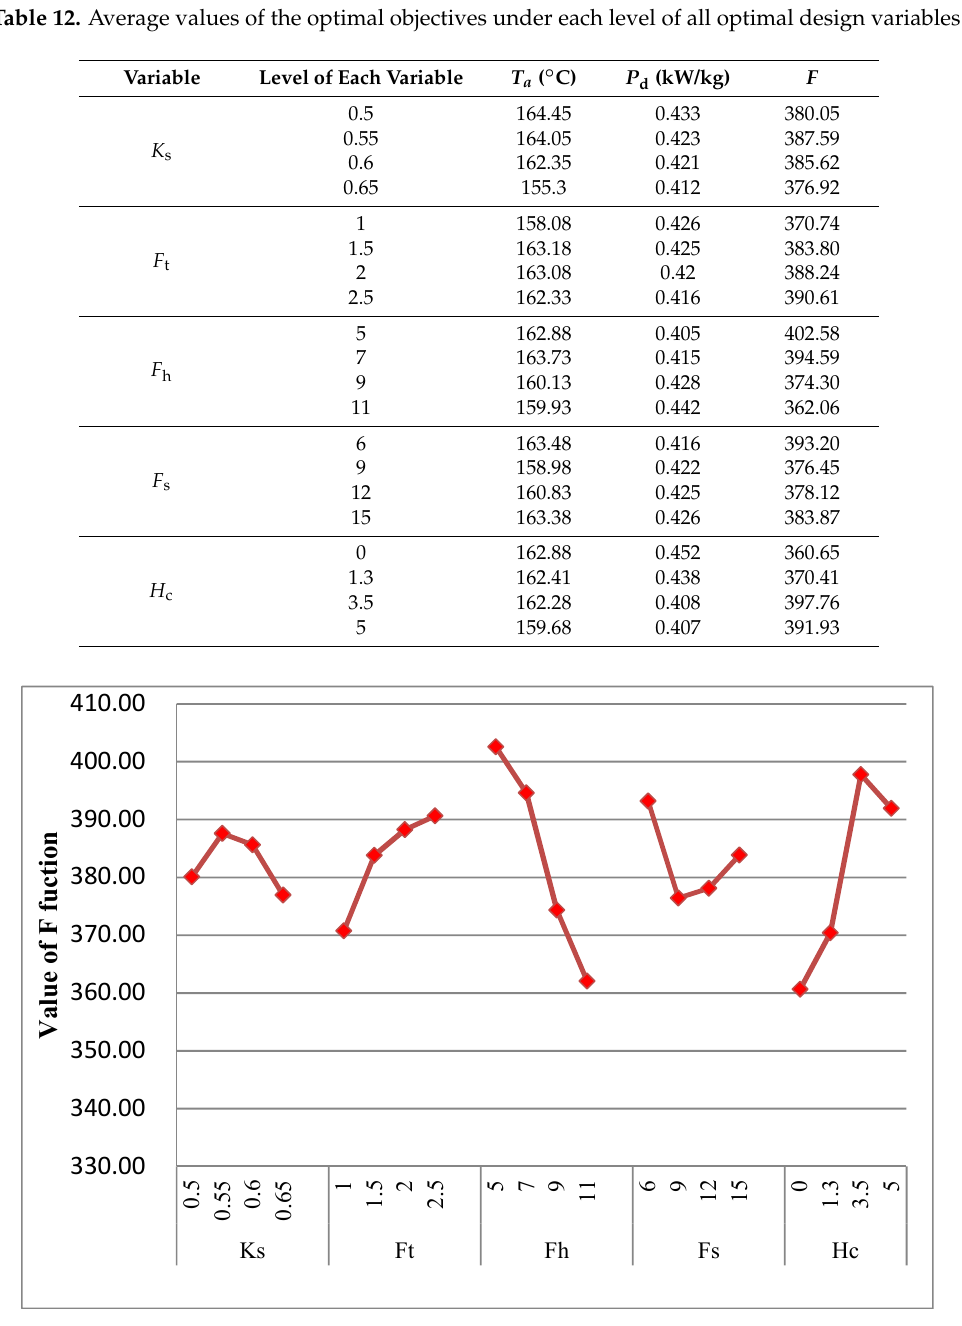
Figure 8. The variation of the value of F function with the variable.